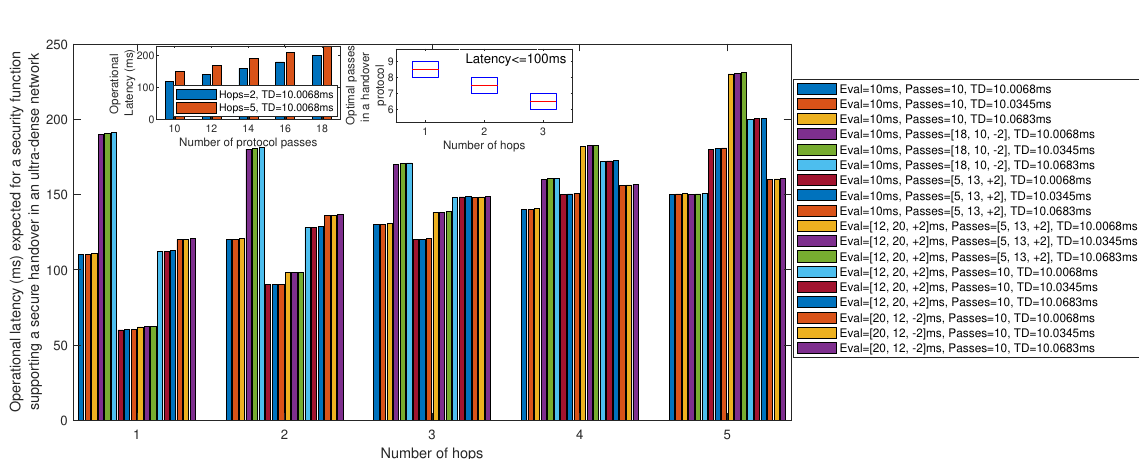
Figure 4. Understanding the expected impact on secure handover latency in terms of operational activity of a security function for 6G networks with variation in the number of hops, evaluation time (Eval), number of protocol passes (Passes), and one-way packet transportation delay (TD).